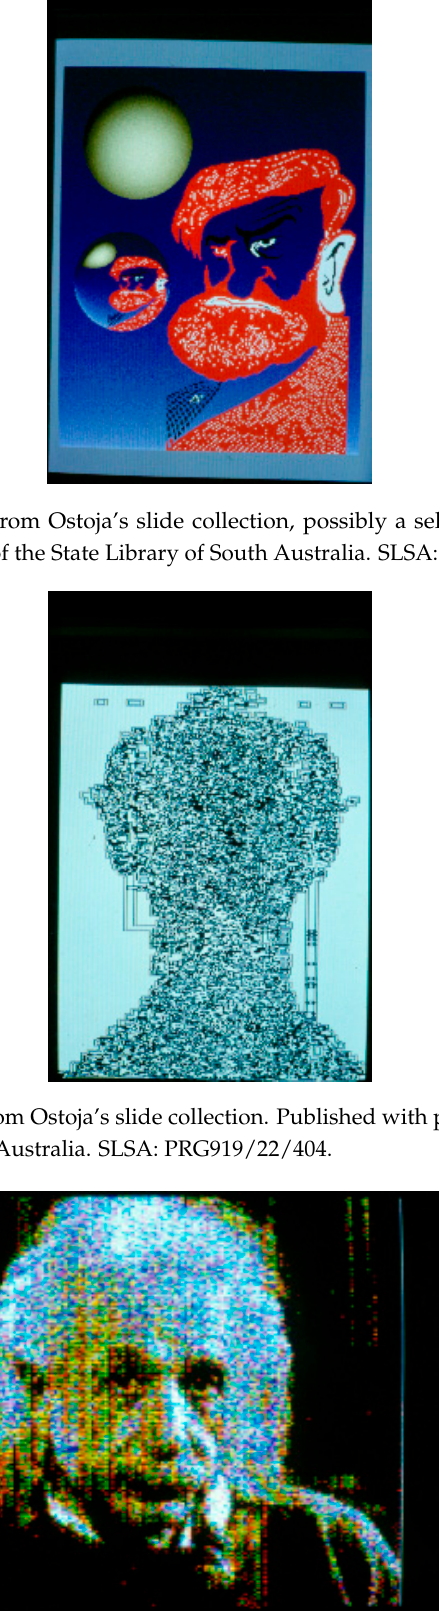
Figure 4. Unnamed image from Ostoja’s slide collection. Published with permission. Image courtesy of the State Library of South Australia. SLSA: PRG919/22/744.